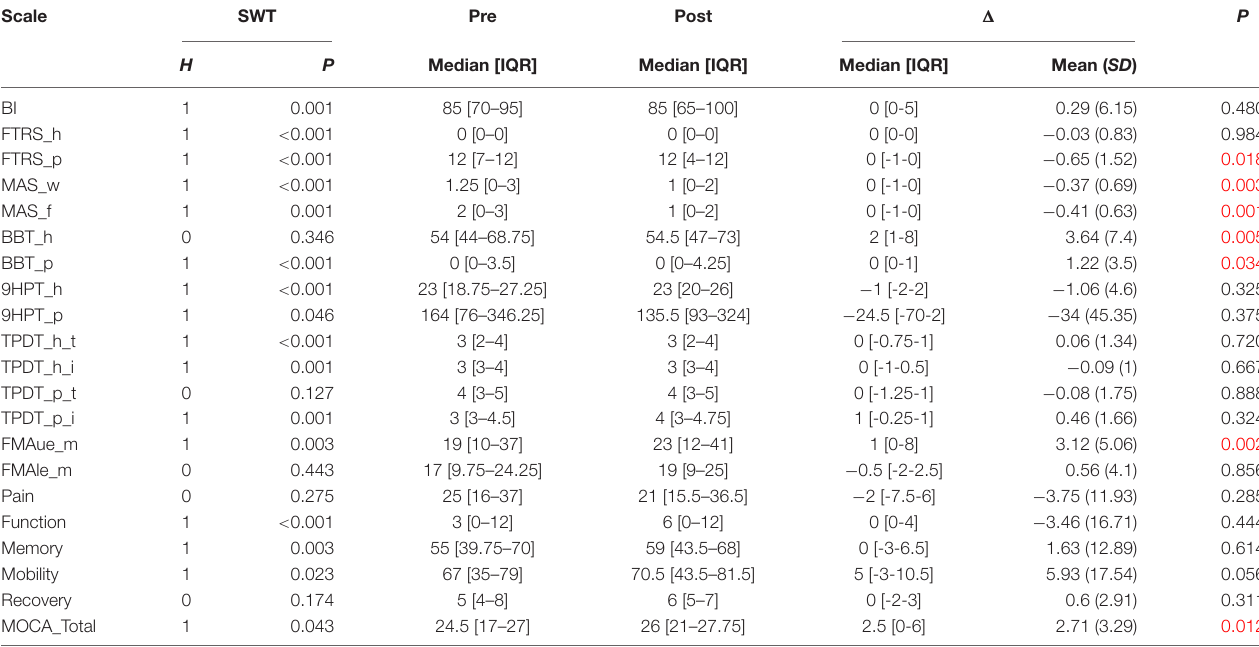
TABLE 6 | Changes in the functional